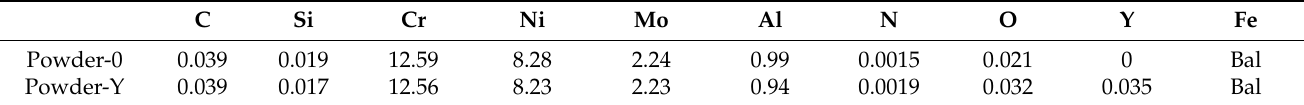
Table 1. Chemical composition of PH13-8Mo stainless steel powders (wt.%).